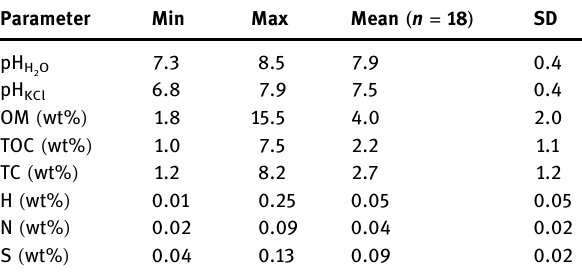
Table 1: Characteristic of foundry